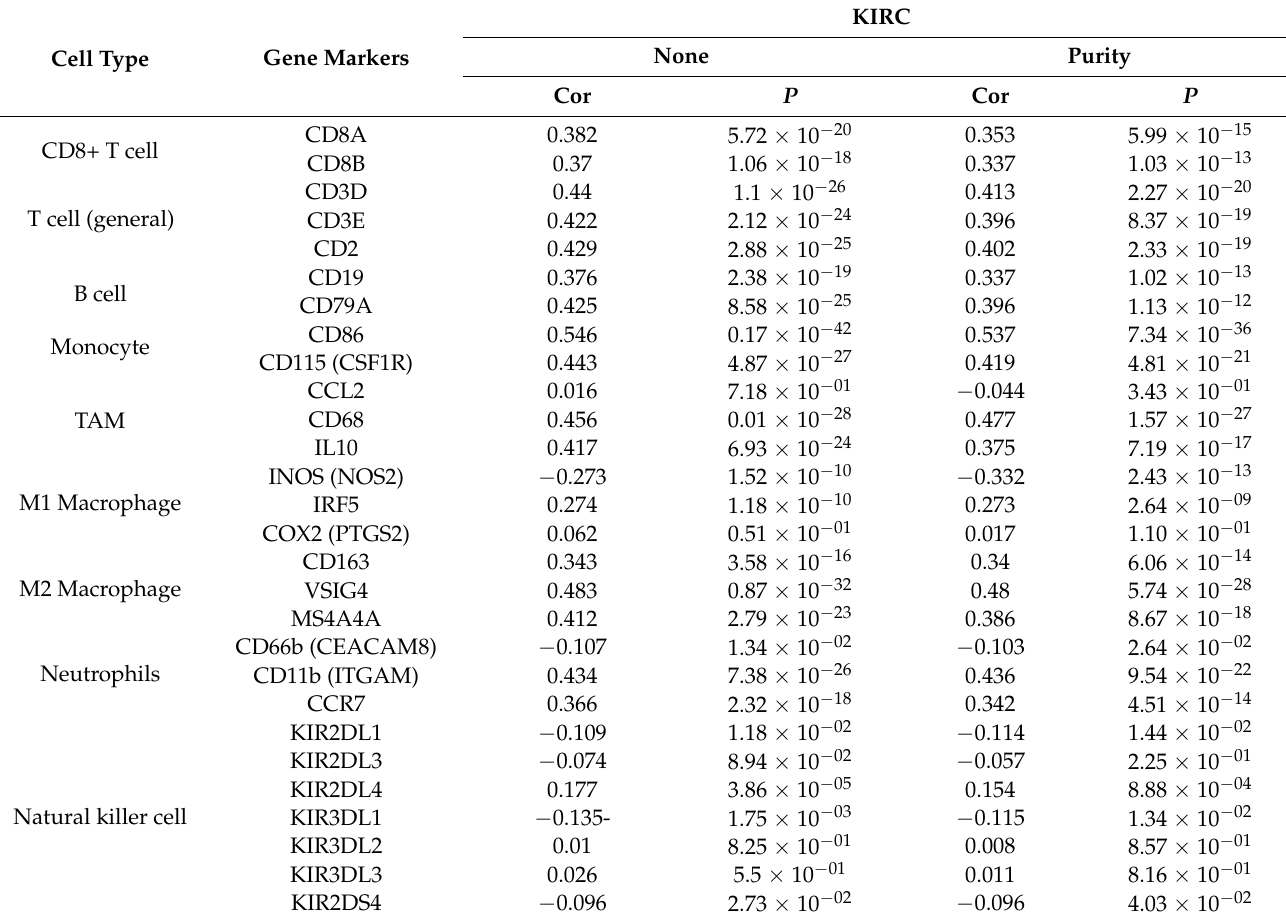
Table 1. Correlation analysis for HAMP and the marker genes of immune cells in